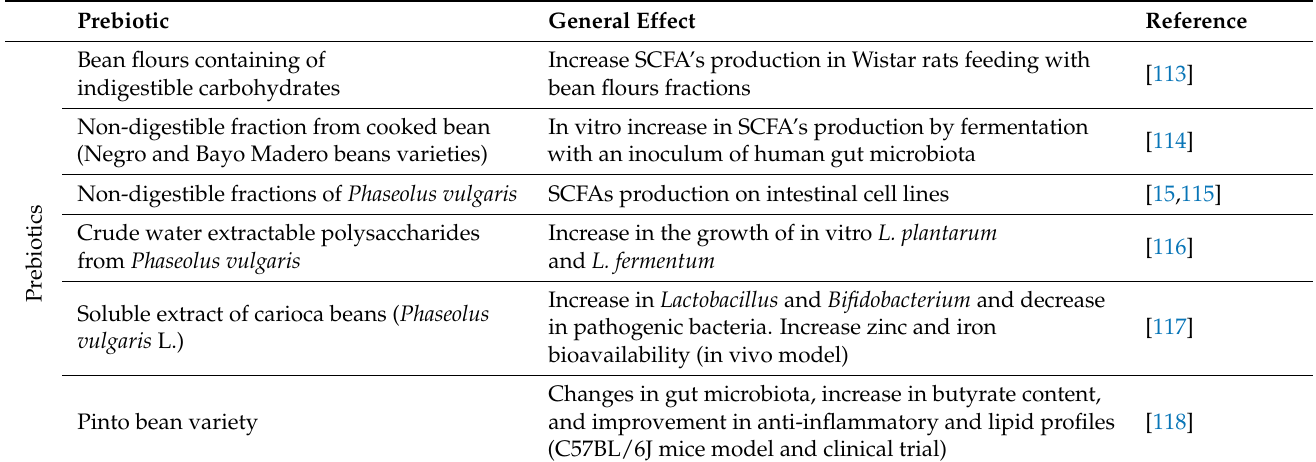
Table 4. Prebiotics in